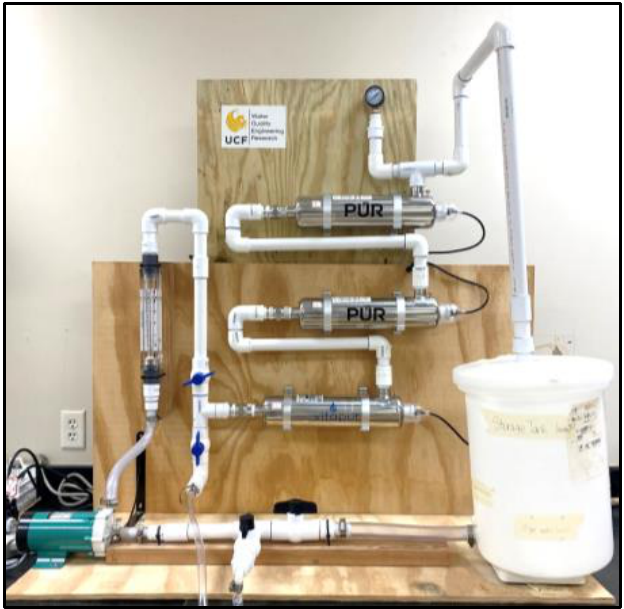
Figure 1. Bench-scale UV pilot.